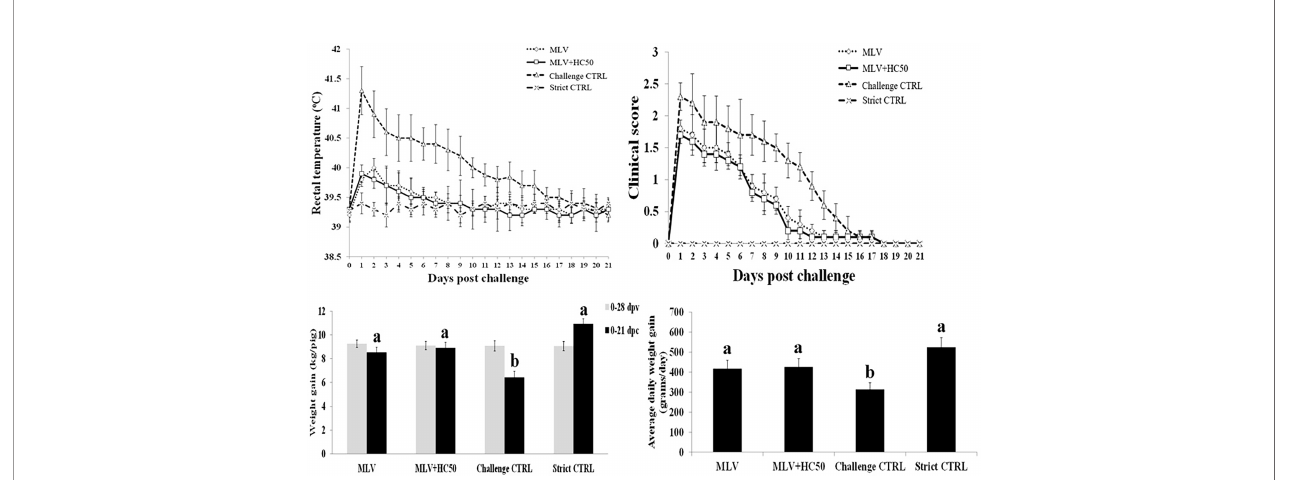
FIGURE 9 | Rectal temperature, clinical score, weight gain (WG), and average daily weight gain (ADWG) of pigs following the HP-PRRSV-2 challenge. Pigs ( n = 6) were injected i.m. with Amervac ® PRRS MLV (0 dpv) (MLV) and Amervac ® PRRS MLV (0 dpv) and fed p.o. with HC50 (0 – 49 dpv) (MLV+HC50) or vaccine solvent used for resuspension of lyophilized Amervac ® PRRS MLV (0 dpv) (Challenge CTRL). The animals were challenged i.n. with HP-PRRSV-2 at 28 dpv (0 dpc). Strict control pigs (Strict CTRL) received no treatment. Rectal temperature and clinical score were recorded daily. WG was calculated from 0 to 28 dpv, and from 0 to 21 dpc. ADWG was calculated from 0 to 21 dpc. One-way repeated measures ANOVA, followed by Dunnett ’ s test was used to determine the signi fi cant difference in mean rectal temperature and clinical score. One-way ANOVA, followed by Dunnett ’ s test, was used to determine the signi fi cant difference in mean WG and ADWG. Error bar indicates the SD. Different letters represent a signi fi cant mean difference among groups ( p <